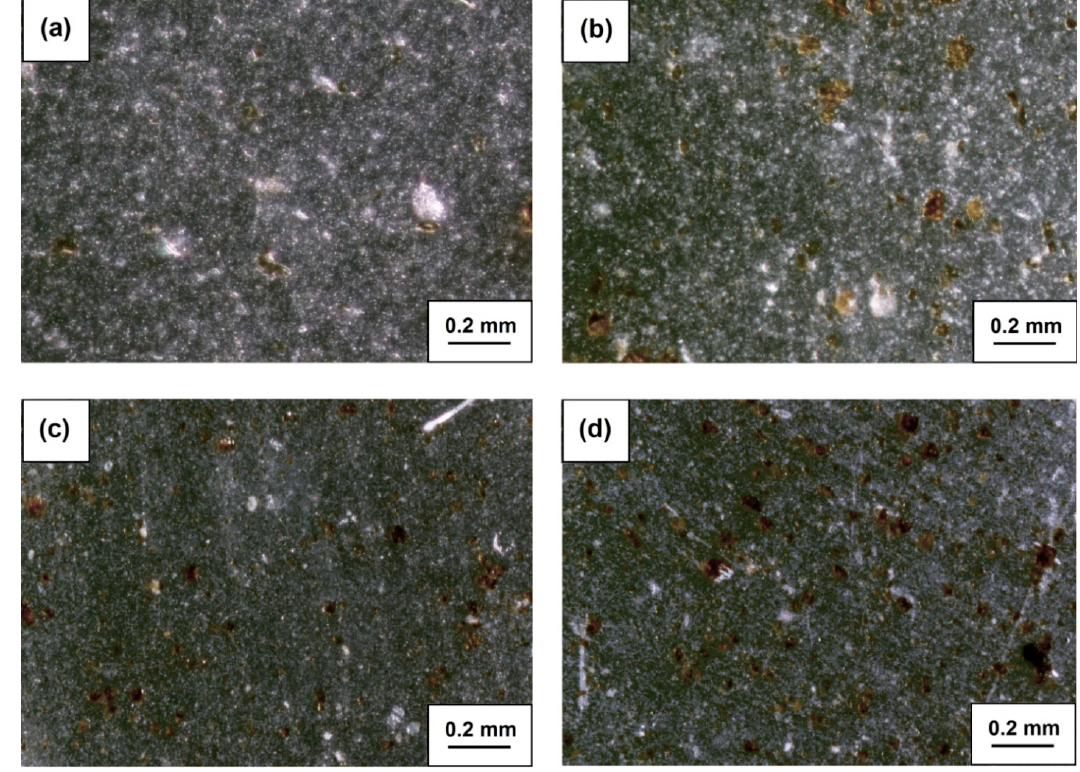
Figure 11. Optical microscopy images of PVC/silica–lignin composites with different filler